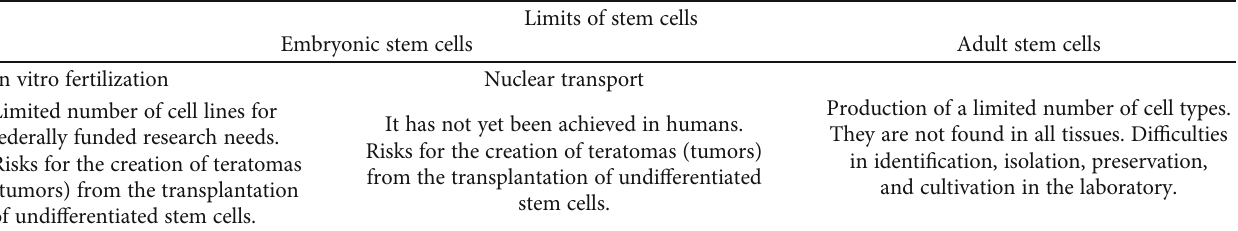
Figure 2: The origin, the collection process, and the plasticity of stem cells: after fertilization of the natural oocyte or in vitro the pluripotent embryonic stem cells are created as internal cell mass inside a blastocyst. The stem cells show that their range of potential is wide and that cells of one tissue can, under experimental conditions and with appropriate culture cell, reprogram to mature cells in another, di ff erent tissue from which they come from. So, they can function as multiples. This is called plasticity and is the basis of cell therapy. Fetal stem cells are found within the organs of the fetus. To this source belongs the embryonic corpse tissue (which can be obtained after a spontaneous abortion due to illness, etc.) and afterwards with the appropriate culture, reprogrammed and functioning such as multipotent cells. Table 2: Main di ff erences and limitations for use of stem